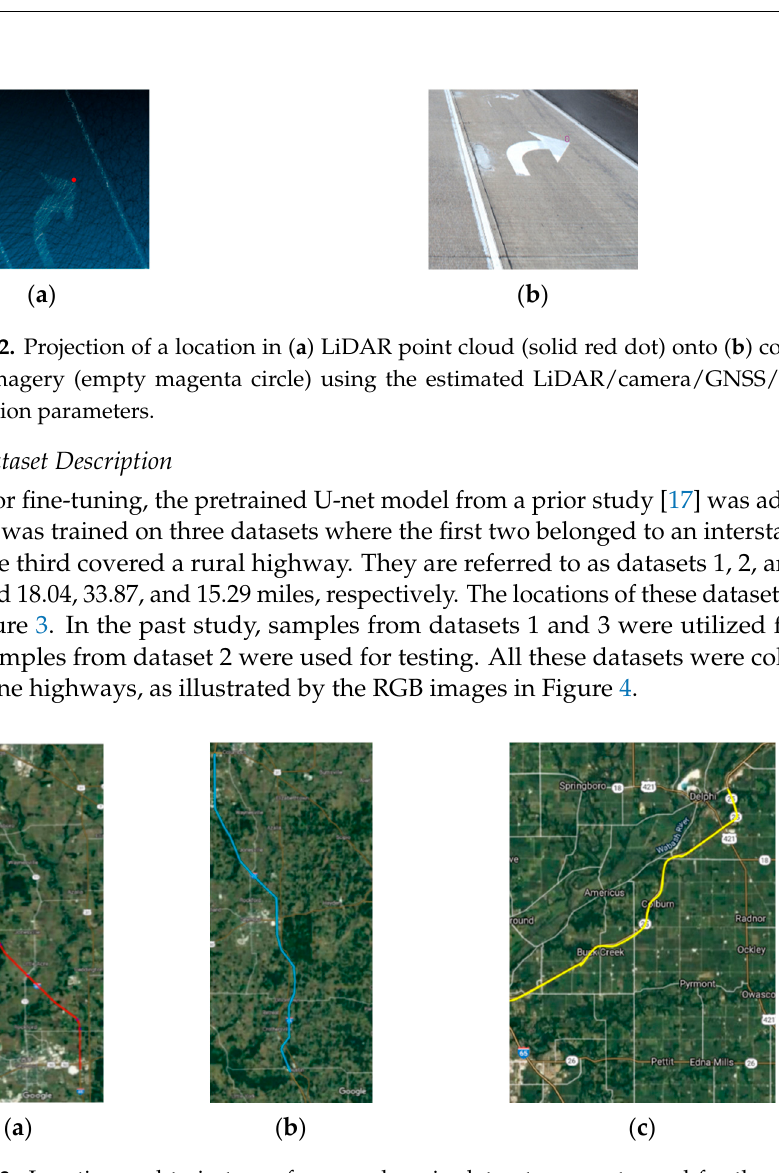
Figure 3. Location and trajectory of source domain dataset segments used for the study in [17]: ( a ) dataset 1, ( b ) dataset 2, and ( c ) dataset 3.